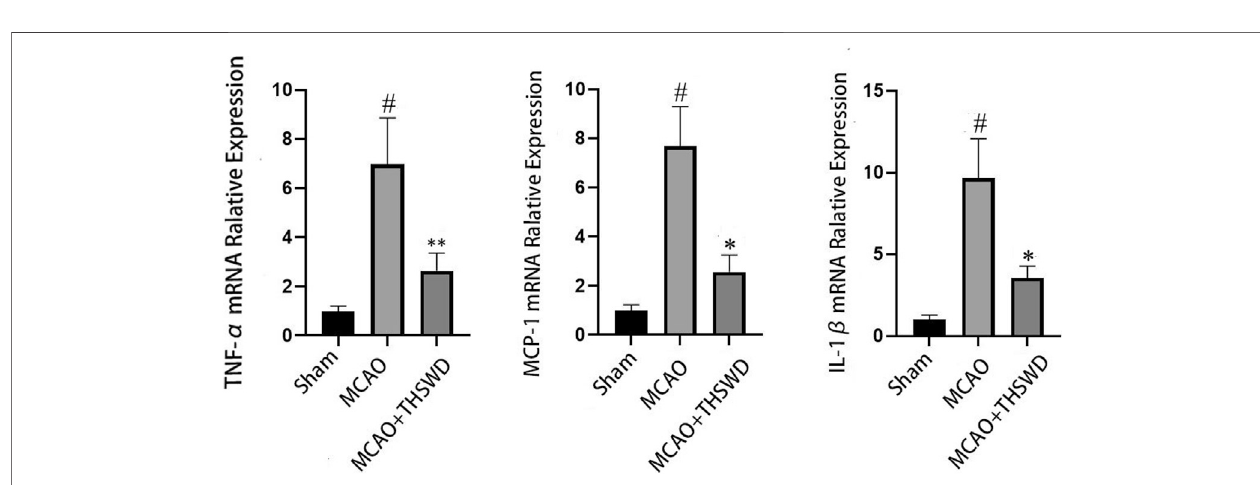
FIGURE 3 | mRNA expression of TNF- α , MCP-1, and IL-1 β . Notes: # P < 0.01 vs Sham operation group; * P < 0.01, ** P < 0.05 vs MCAO group.